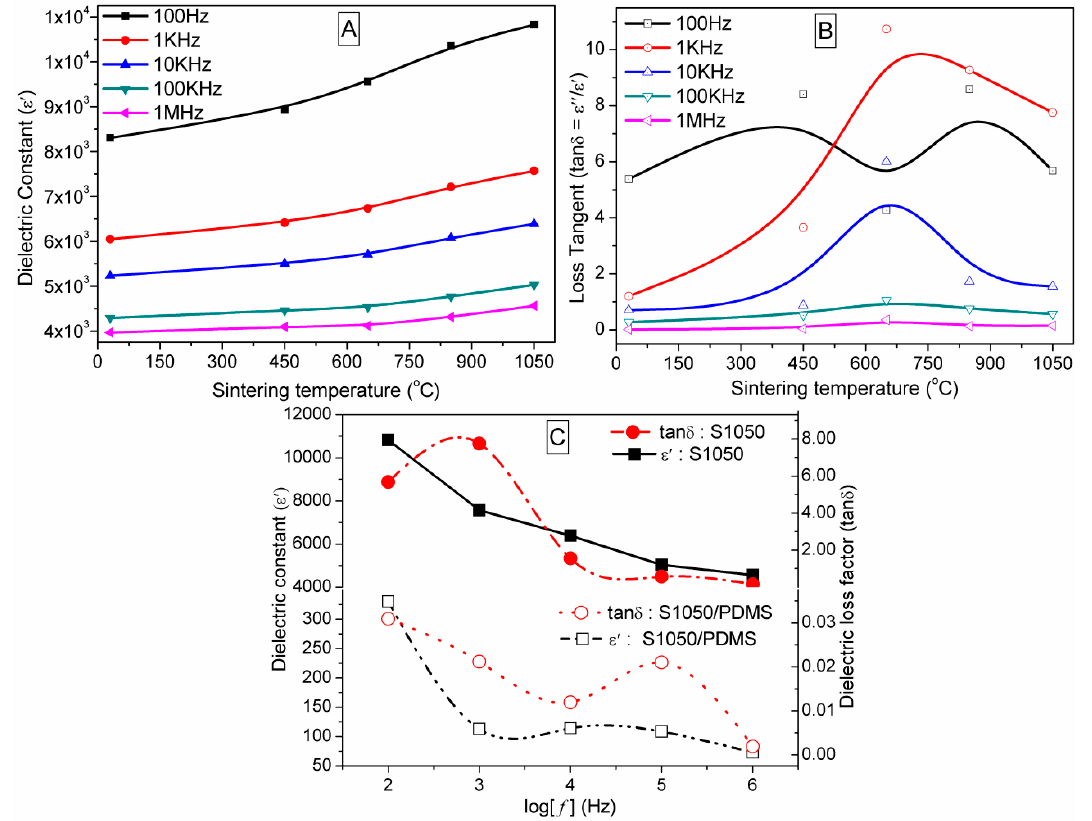
Figure 11. ( A ) Dielectric constant ( ε′ ) and ( B ) dielectric loss tangent (tan δ ) of unsintered (25 °C) ceramics pellet and sintered pellets, which were sintered at 450 °C (S450), 650 °C (S650), 850 °C (S850), and 1050 °C (S1050) at different frequencies 100 Hz (black), 1 kHz (red), 10 kHz (blue), 100 kHz (olive green), and 1 MHz (pink), ( C ) A typical comparisons in ε′ and tan δ of S1050 ceramic and S1050/PDMS composite film at the different log( f ).